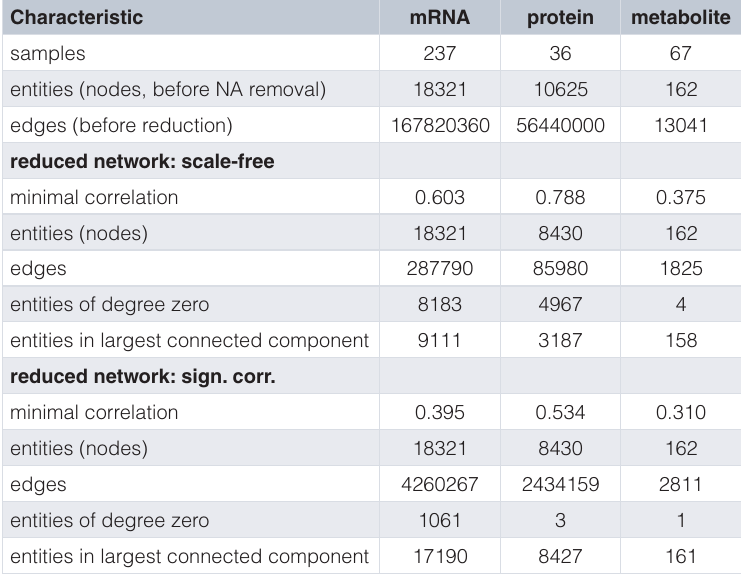
Table 1. Characteristics of the networks derived from the three data layers. Note that genes/proteins/metabolites were removed if having >20% NA values (which was the case only for proteins), all other entities were kept as nodes in the reduced network even if their degree was zero (i.e. having no edge) after network